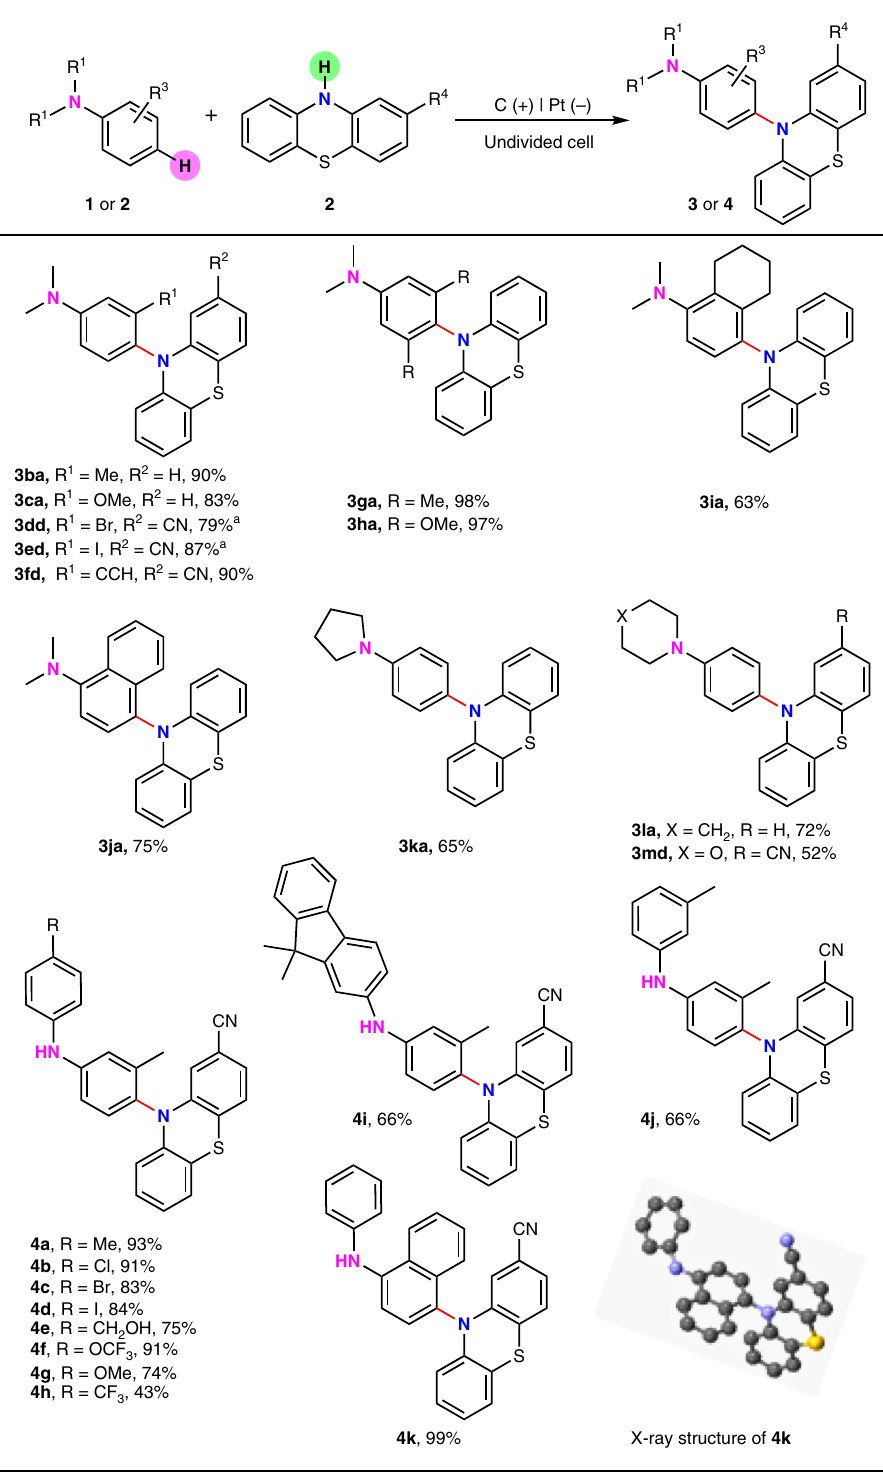
Fig. 3 para -Selective C – H amination of different anilines. Reaction conditions: graphite rod anode ( ϕ 6 mm), platinum plate cathode (15 mm × 15 mm × 0.3 mm), constant current = 7 mA ( J anode ≈ 7.8 mA cm − 2 ), n Bu 4 NBF 4 (0.15 mmol), 1 (0.30 mmol), 2 (0.20 mmol), MeCN/MeOH (7.0 mL/3.0 mL), room temperature, N 2 , 2.0 h (2.6 F). Isolated yields were shown. a Constant current = 10 mA ( J anode ≈ 11 mA cm − 2